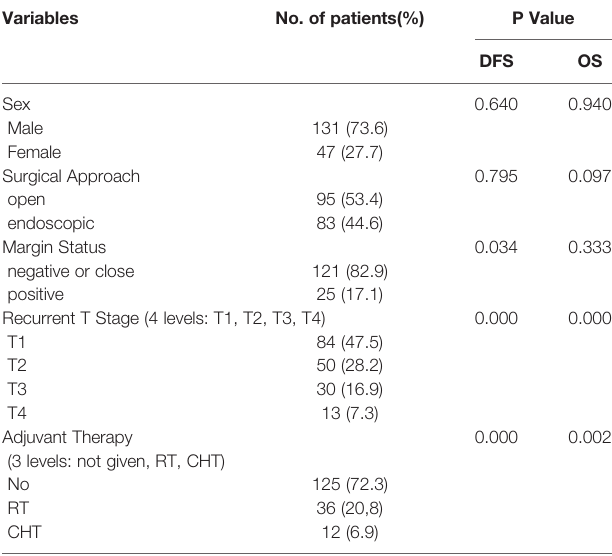
TABLE 2 | Clinical Characteristics and univariate analysis of prognostic